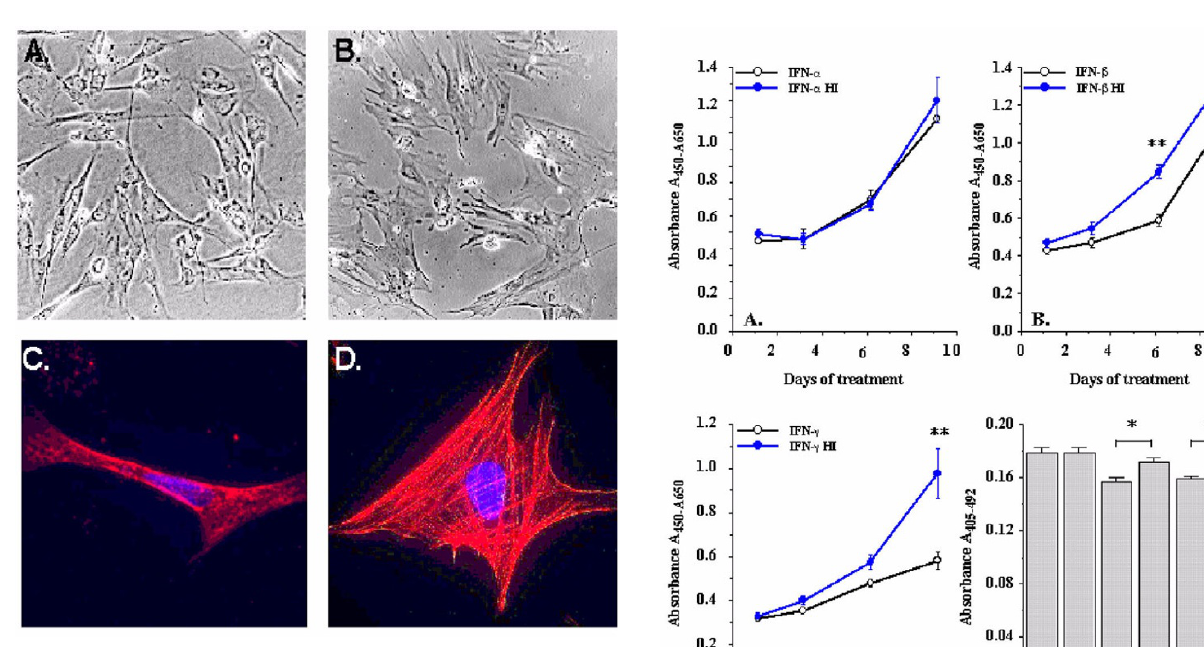
Figure 1 Morphology of sub-cultured rat HSCs and expression of SMA in HSCs. HSC morphology under phase-contrast micro- scope at days 3 and 12 was shown at panels A and B respec- tively. The expression of SMA in HSCs at the same days was presented in panels C and D.